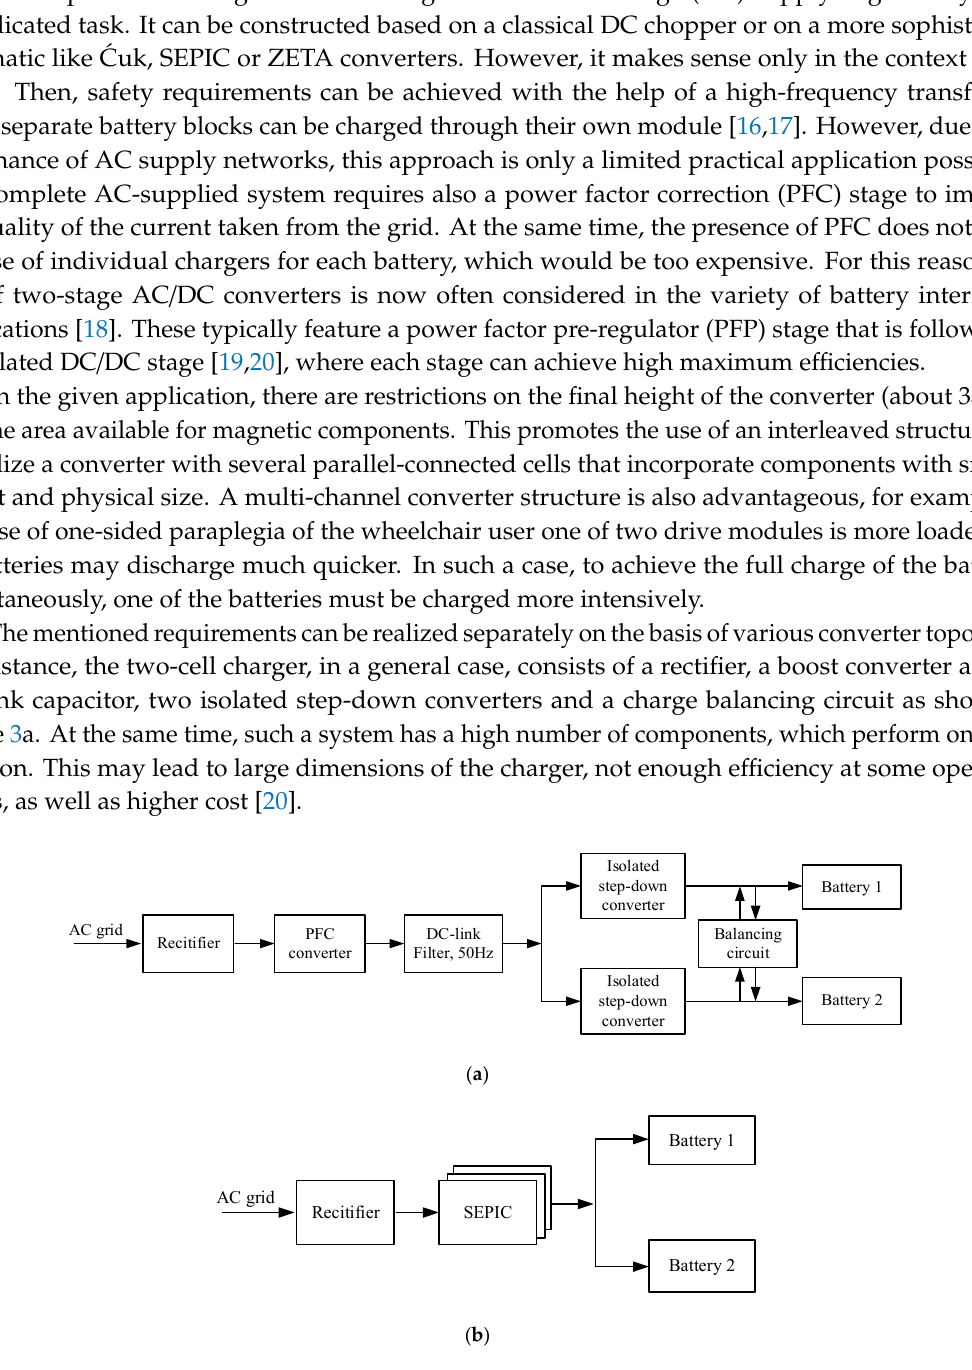
Figure 3. Typical ( a ) and proposed ( b ) charging system